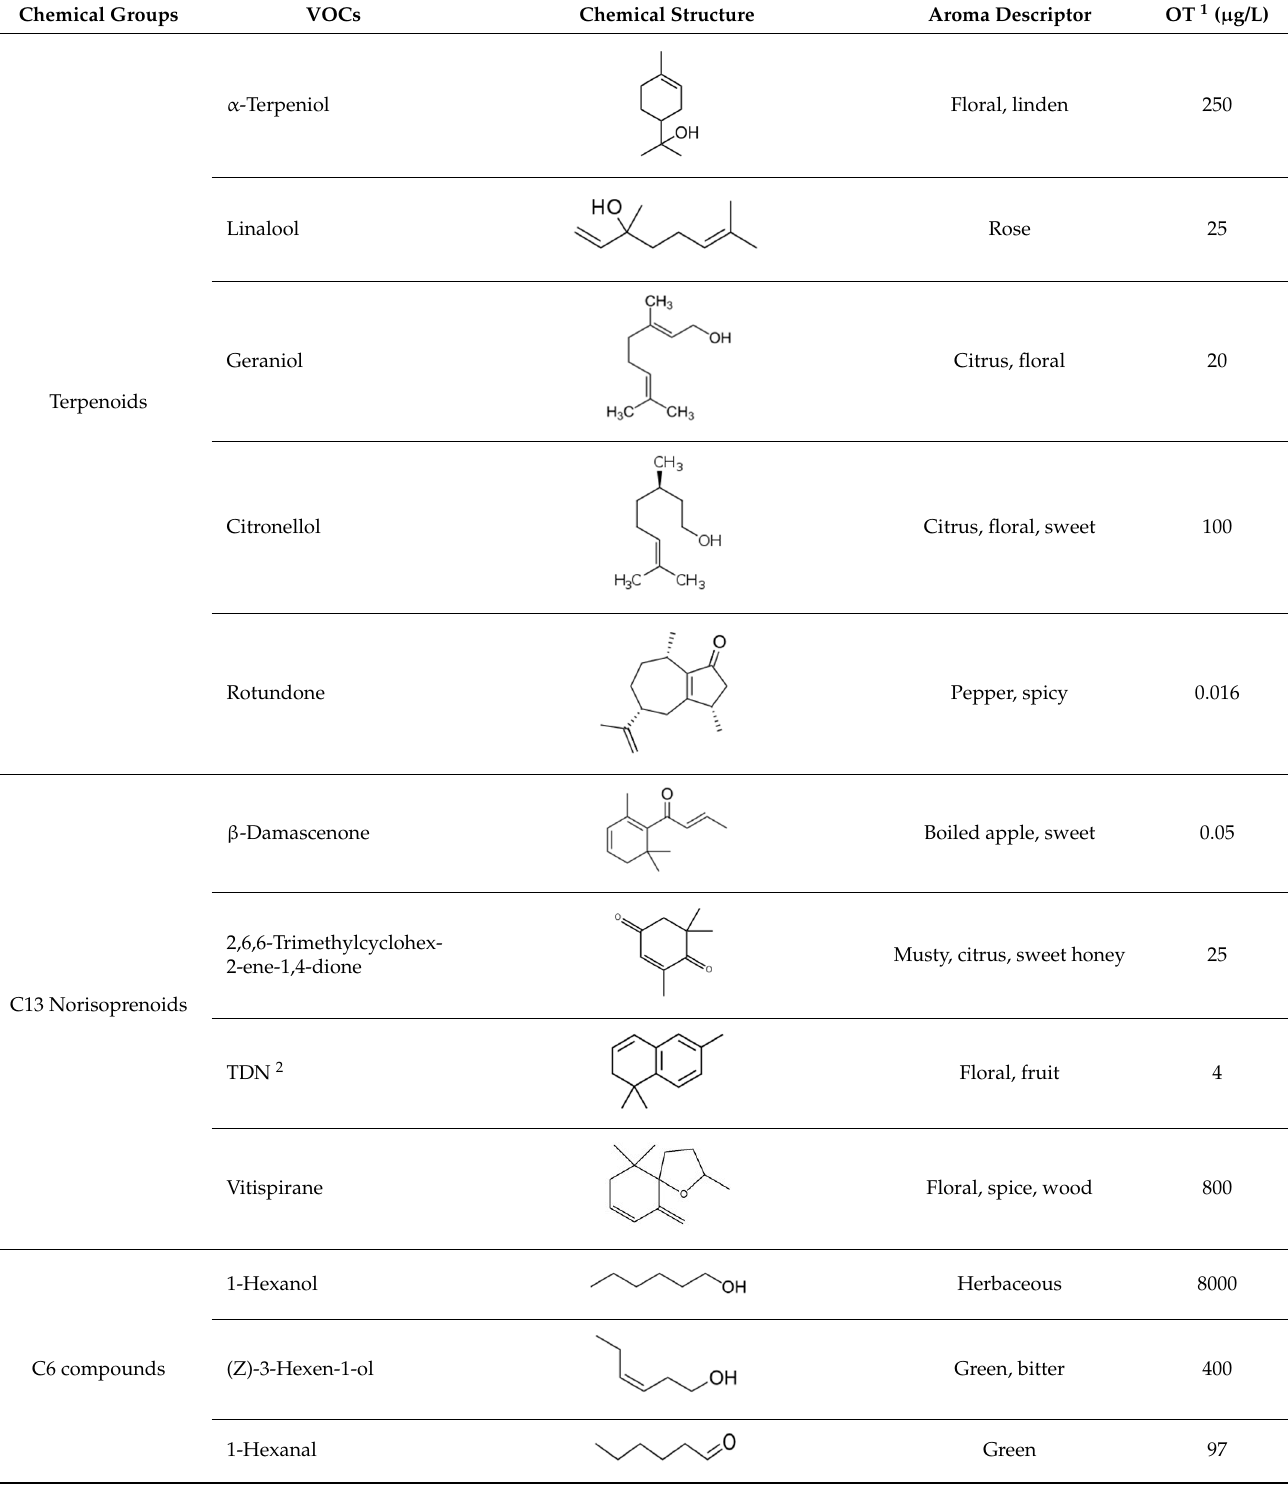
Table 1. Some important volatile organic compounds (VOCs) identified in fortified wines, chemical structure, aroma descriptors, and odor threshold (OT) [4–11].